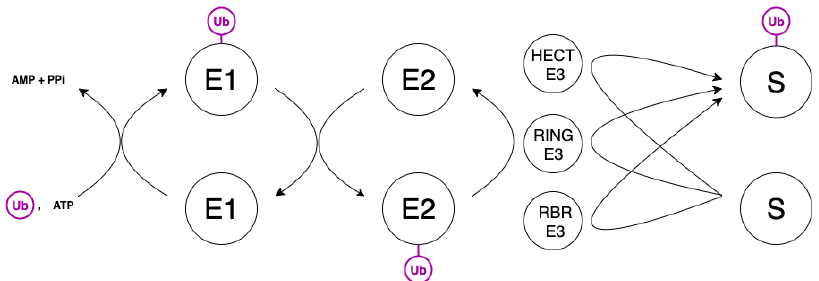
Figure 3. Scheme of the ubiquitination process in mammalian cells. Ubiquitin (Ub) is initially activated by the formation of an acyl phosphate with ATP, which then acylates the cysteine group of the E1 protein. Ub is then transferred from E1 to a cysteine of one of the members of the E2 family, which interact with proteins of the large family of E3 ubiquitin ligases. E3 ligases are usually classified into three main classes (RING, HECT, and RBR) based on conserved structural domains and the molecular mechanism of Ub transfer to the substrate protein. Sites of ubiquitination vary among different substrates. For most proteins, the first Ub moiety is conjugated to an ε -NH2 group of an internal Lys residue.